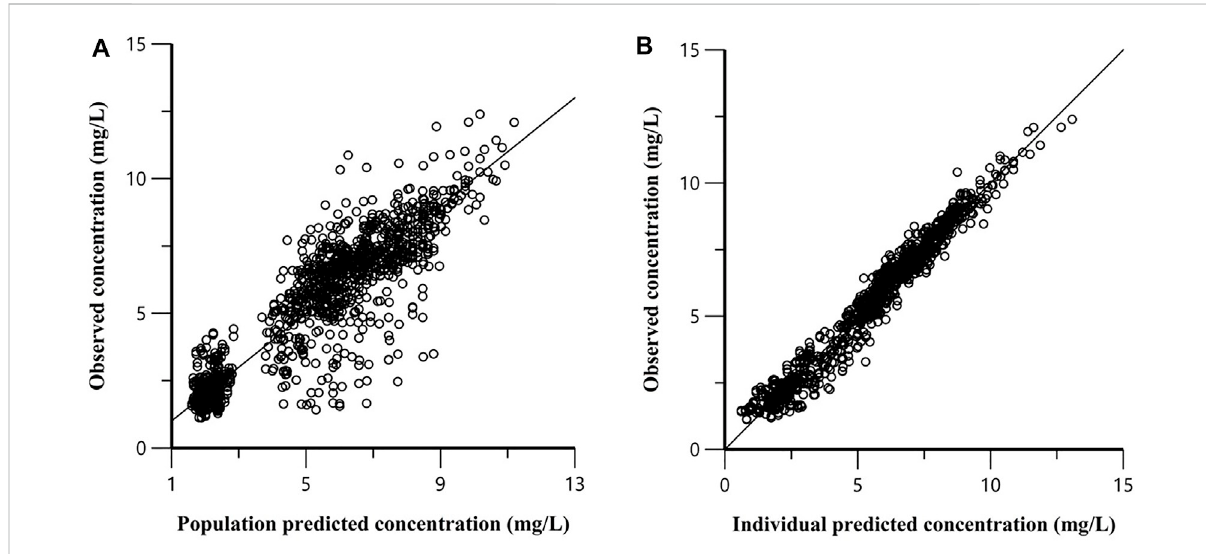
FIGURE 2 Goodness-of- fi t plot for the fi nal model. (A) Population predicted versus population observed concentrations; (B) Individual predicted versus individual observed